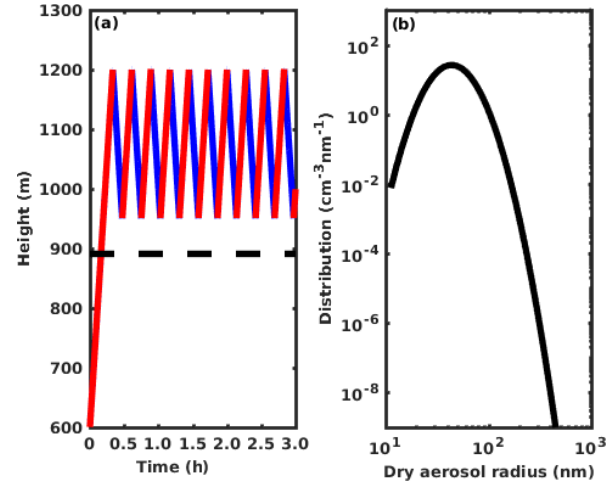
Figure 1. (a) Trajectory of cloud parcel with upward and down- ward oscillations. Velocity is constant and is 0 . 5 for the ascending parcel and − 0 . 5ms − 1 for the descending parcel. The dashed line is the cloud base, and the red and blue lines represent ascending and descending parcels, respectively. (b) Initial dry aerosol size distri- bution. The total aerosol number concentration is 1000cm − 3